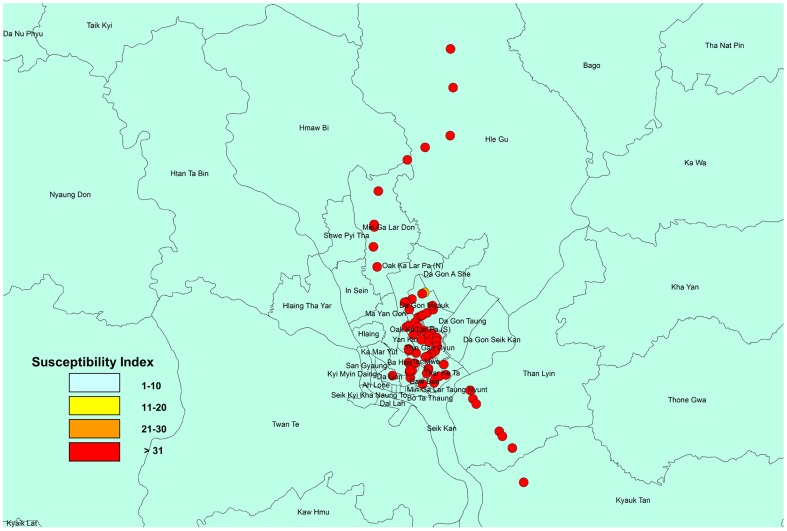
Distribution of susceptibility indices in Aedes aegypti larvae.The susceptibility index was determined by using the simplified knockdown bioassay. The color in each circle indicates the susceptibility index. The larger the index, the lower the susceptible to d-allethrin.